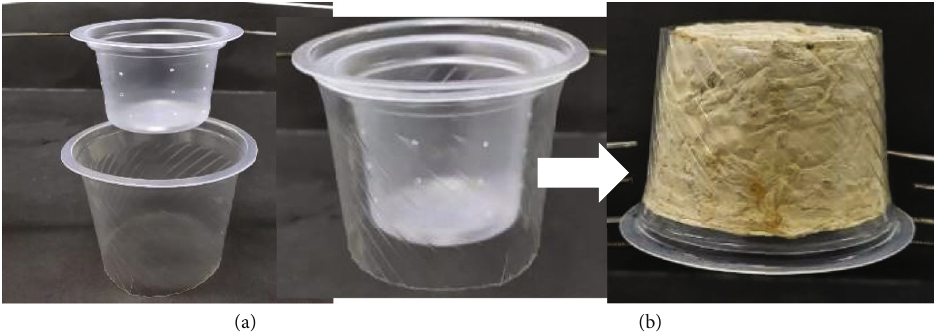
Figure 2: Polypropylene plastic cup for biofoam cup casting: (a) before use and (b) after